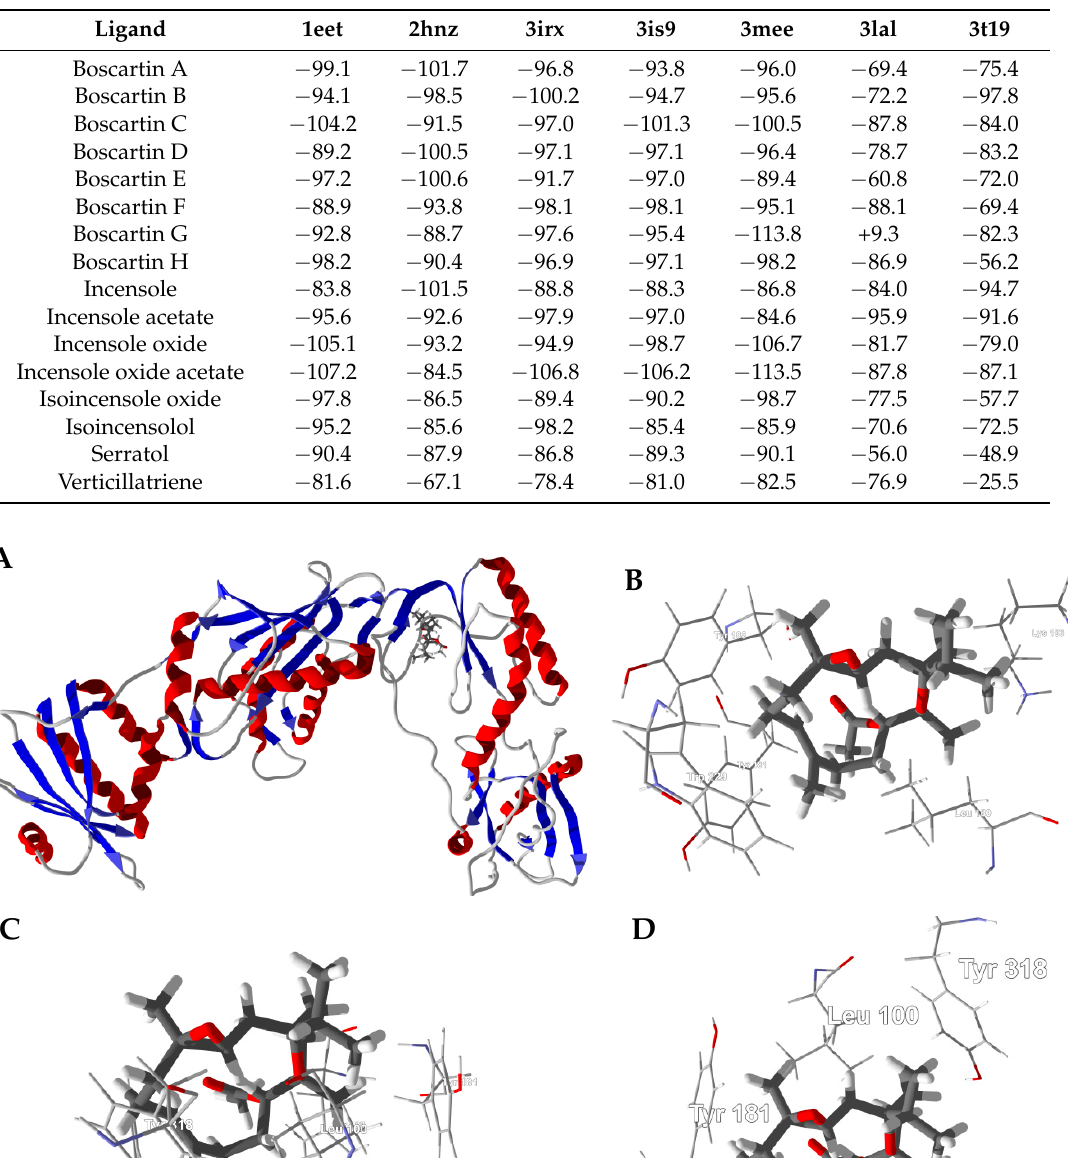
Table 4. MolDock molecular docking energies (kJ/mol) of Boswellia cembranoids with human immunodeficiency virus type 1 reverse transcriptase (HIV1-RT).